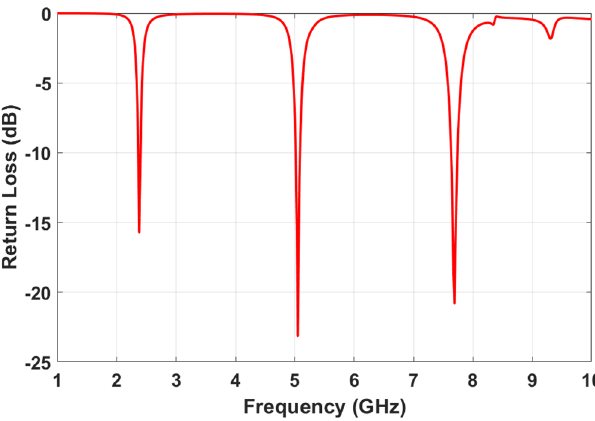
Figure 17. SIW-cavity MPA’s return loss before etching